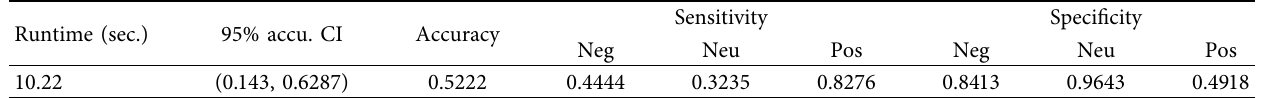
Table 4: Performance statistics of the random forest model.